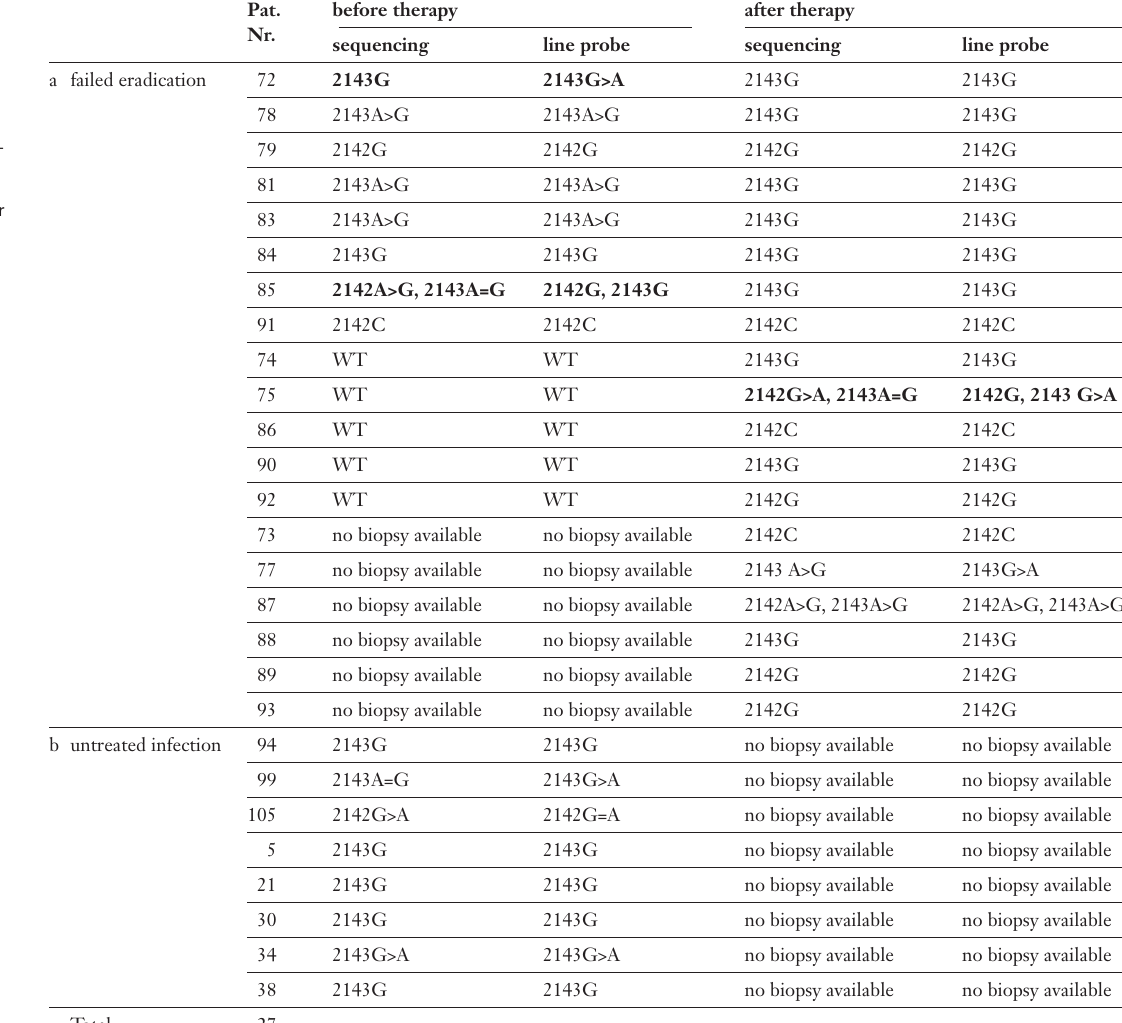
Table 2 Comparison of the two molecular biological methods sequencing and line probe hybridisation for resolution of uni- form mutated and mixed mutated/WT populations in either pre- or post-thera- peutic antrum biop- sies (bold: one moi- ety detected by only one